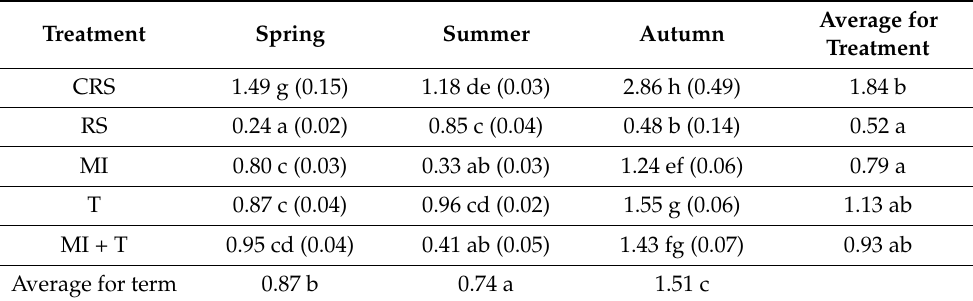
Means marked with the same letters do not differ significantly at α = 0.05. Values in brackets represent standard